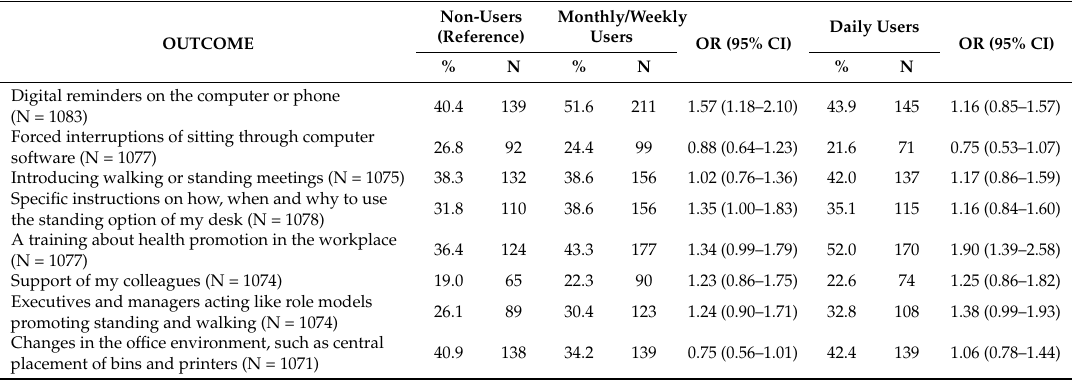
Table 6. Agreement with feasibility of potential interventions to reduce sitting time at work per user